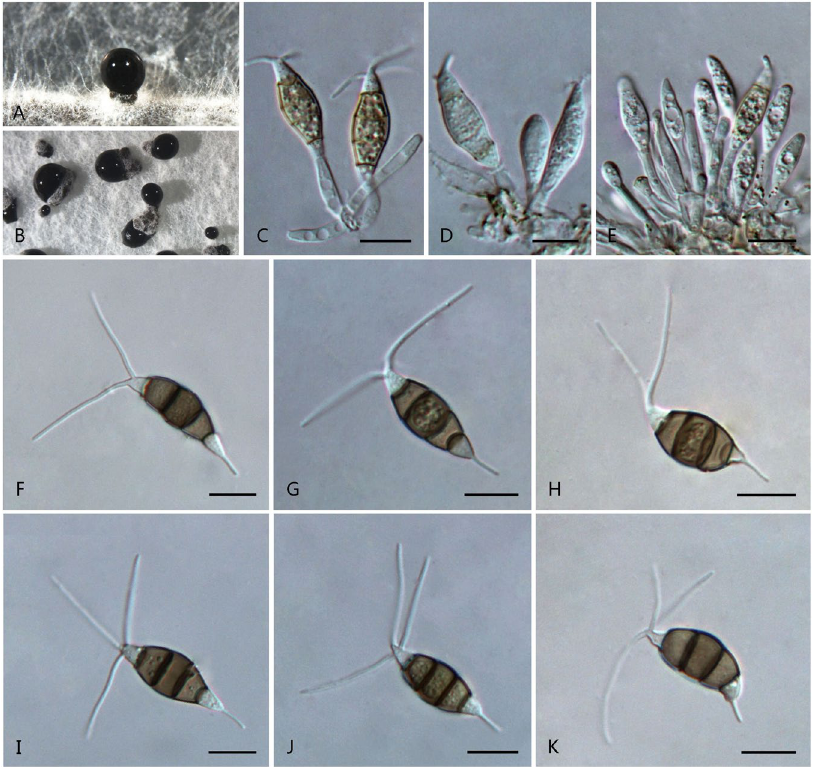
Figure 12. Pestalotiopsis lushanensis (from ex-holotype culture CGMCC 3.18160 ( = LC4344)). ( A ) Conidioma sporulating on pine needle. ( B ) Conidiomata sporulating on PDA. ( C–E ) Conidiogenous cells and conidia. ( F–K ) Conidia. Scale bars = 10 μ